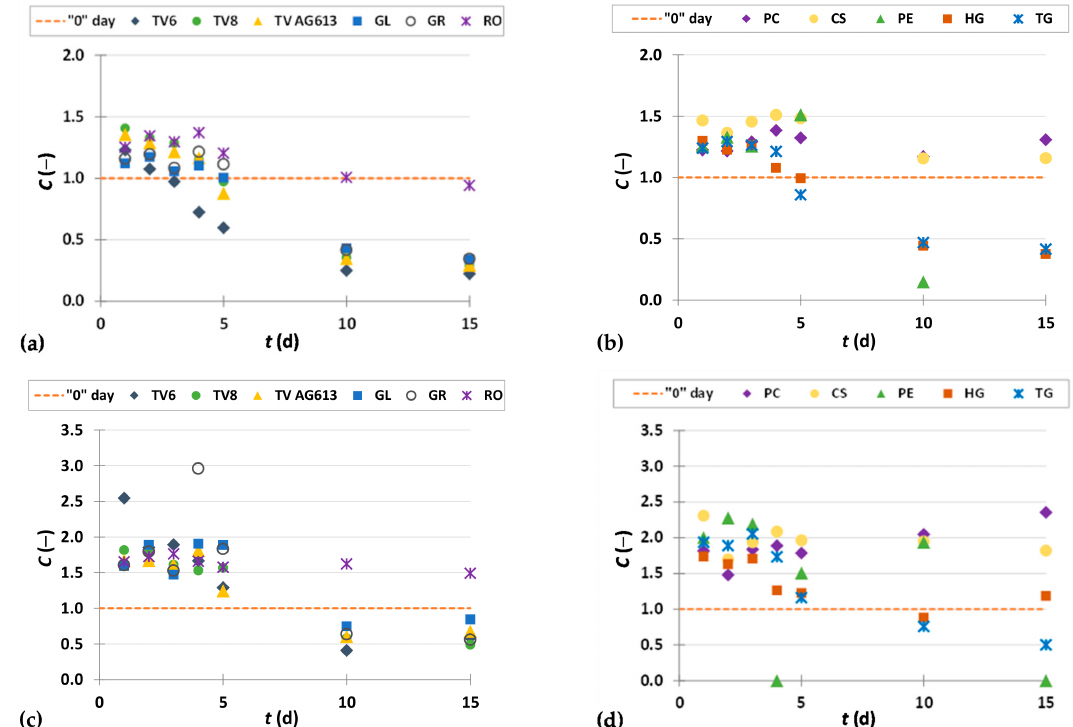
Figure 10. Dimensionless content ( C = C i / C o ) of resveratrol ( a , b ) and ε -viniferin ( c , d ) in GP extracts before biological treatment (‘0’ day) and after 1–15 days of biological treatment with TV6, TV8, TV AG613, GL, GR, RO ( a , c ), and PC, CS, PE, HG, TG ( b , d